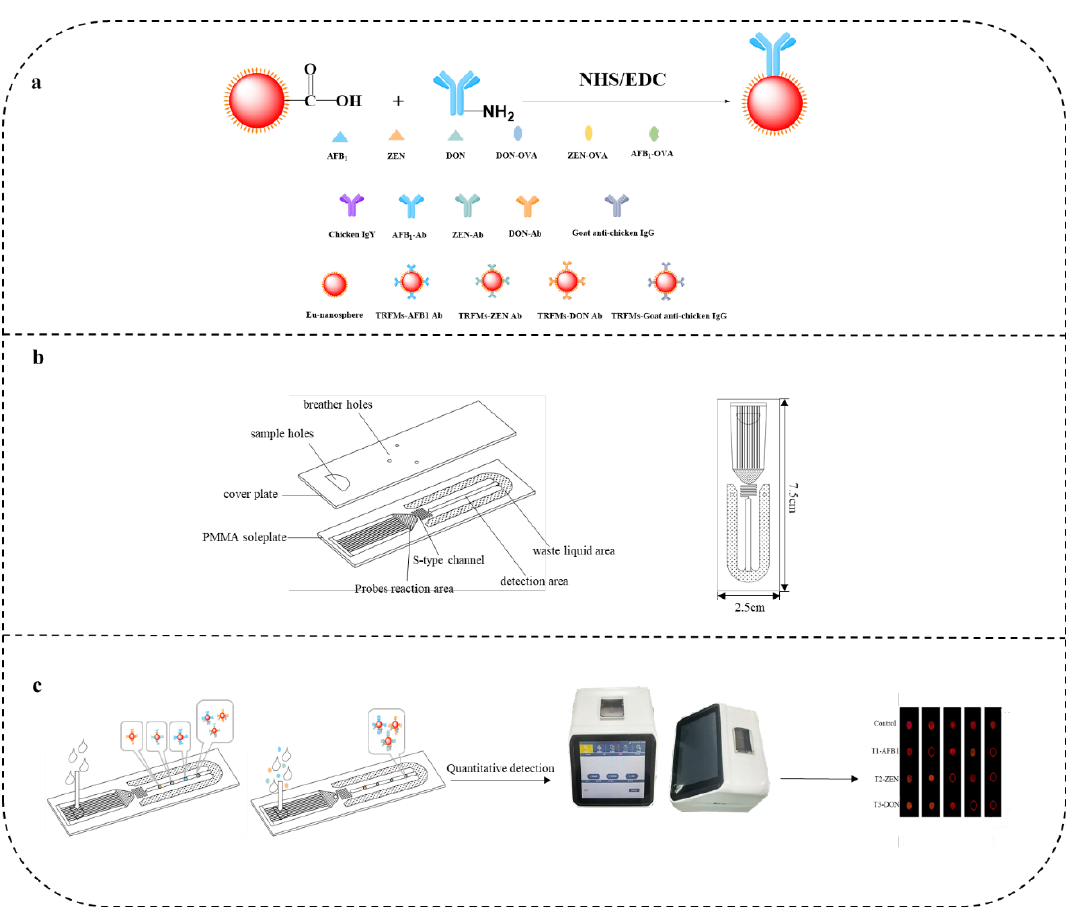
Figure 2. Schematic diagrams of the microfluidic chip for AFB 1 /ZEN/DON, and interpretation of test results: ( a ) principles of immunoprobe preparation; ( b ) schematic diagram of microfluidic chip; ( c ) detection principle of microfluidics chip; the EM wavelength of fluorescent microspheres was 365.0 nm, the EM wavelength was 650 nm, and the scanning range was from 500.0 nm to 700.0 nm.